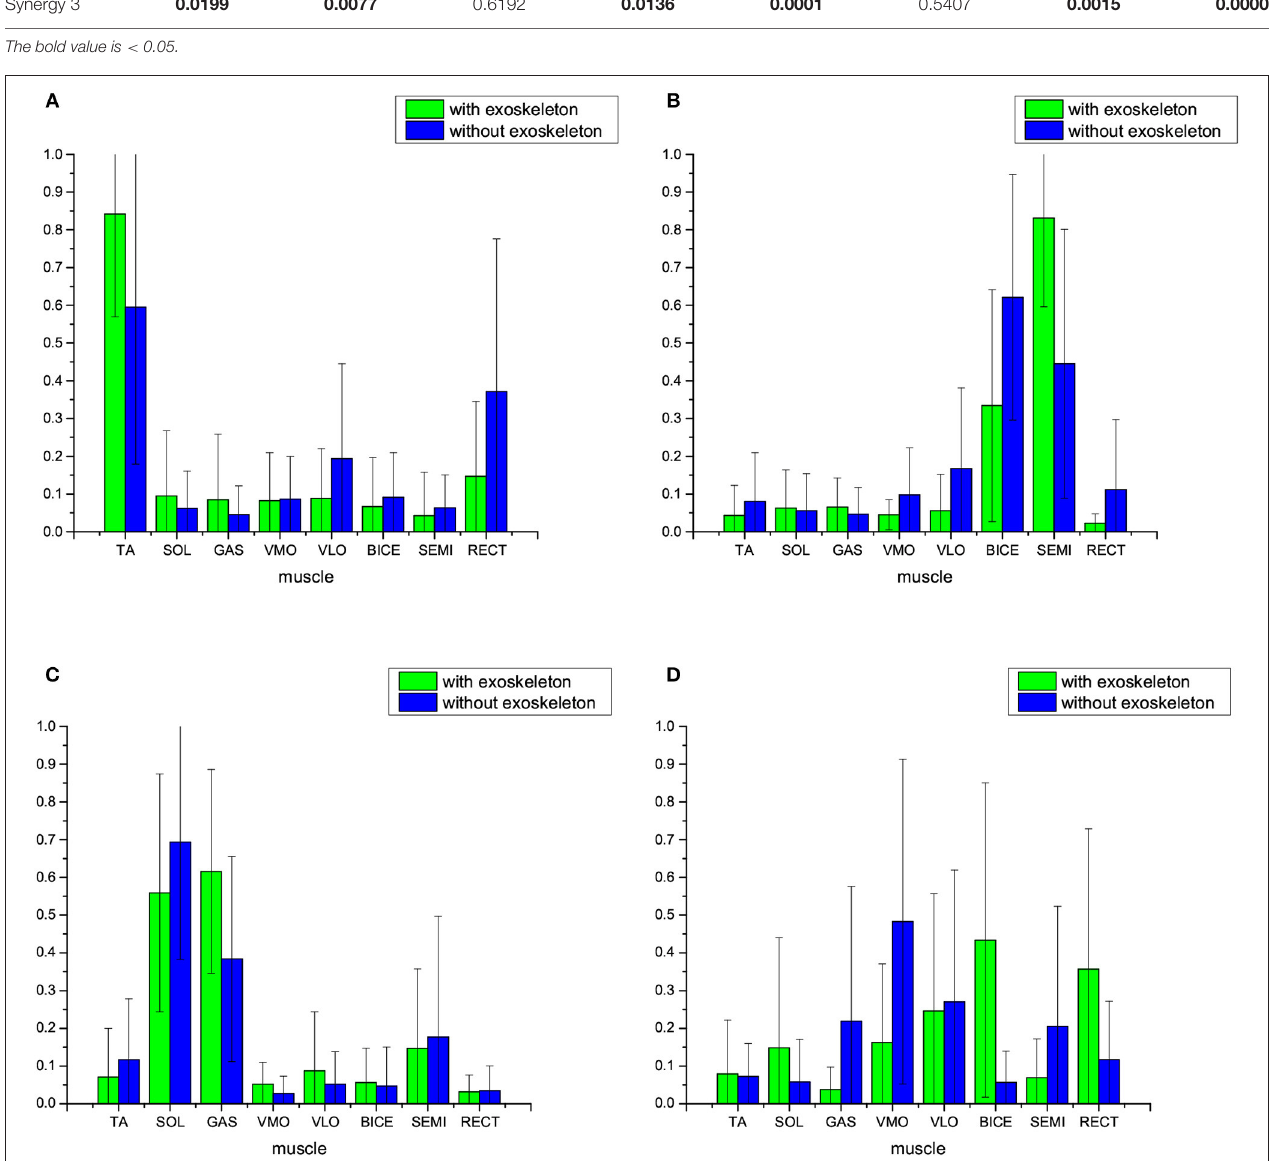
FIGURE 4 | Average muscle synergies of the 17 subjects who walk with and without lower-limb exoskeletons. NMF is used to exact the muscle synergy, with the reduced dimension being k = 4. (A) Synergy 1, (B) Synergy 2, (C) Synergy 3, and (D) Synergy